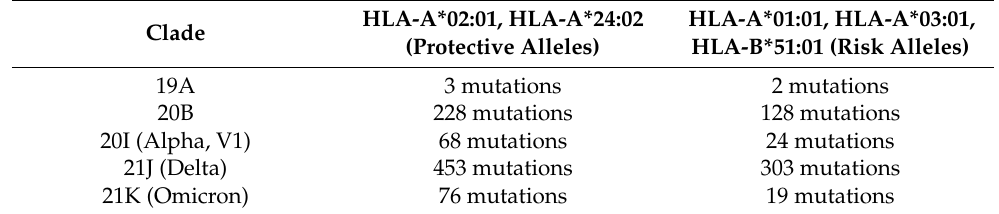
Table 1. Absolute count of sequences harboring private mutations in HLA epitopes across clades. HLA-A*02:01, HLA-A*24:02 HLA-A*01:01, HLA-A*03:01, Clade (Protective Alleles) HLA-B*51:01 (Risk Alleles) 19A 3 mutations 2 mutations 20B 228 mutations 128 mutations 20I (Alpha, V1) 68 mutations 24 mutations 21J (Delta) 453 mutations 303 mutations 21K (Omicron) 76 mutations 19